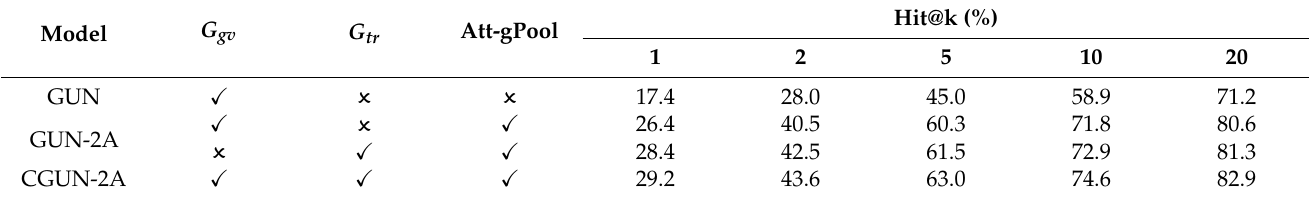
Table 4. Results for the ablation study for 2-hops. G gv and G tr represent graphs encoded by the encoders Glove and Transformer, respectively.